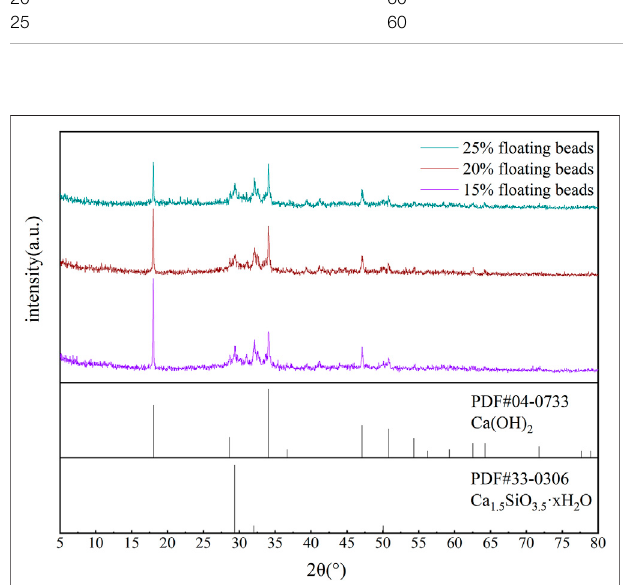
FIGURE9| Phaseanalysisofthecementstonewithdifferentamountsof fl oating beads.